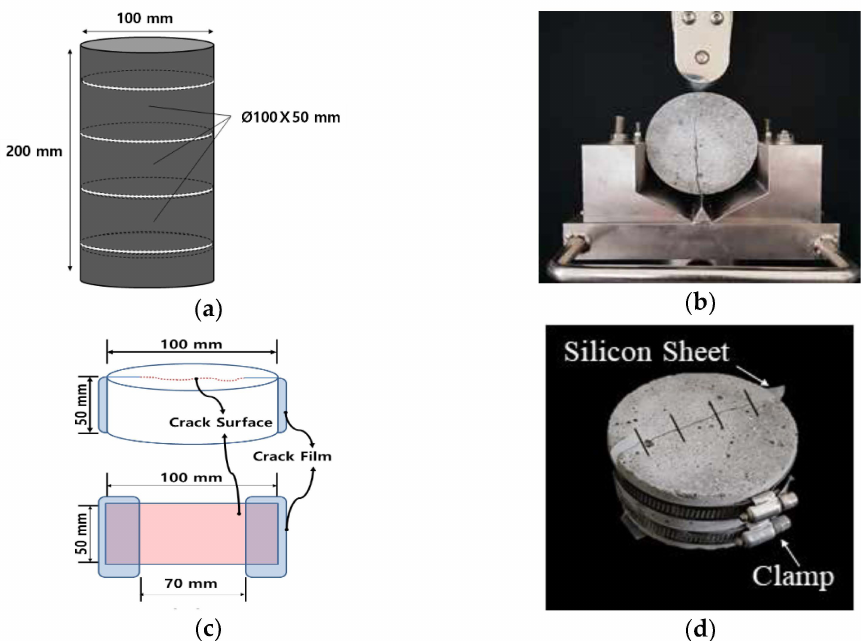
Figure 5. Preparation of cracked specimens: ( a ) slicing into three disc specimens, ( b ) split specimen, ( c ) crack induction, and ( d ) specimen bound together with two steel